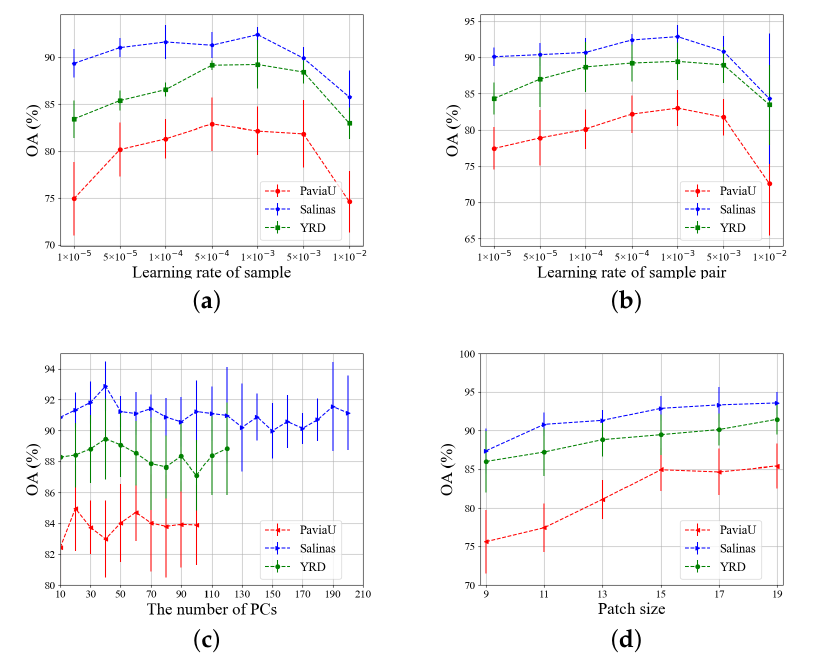
Figure 7. Evolution of OA (%) as a function of ( a ) Learning rate of sample, ( b ) Learning rate of sample pair, ( c ) The number of PCs, ( d ) Patch